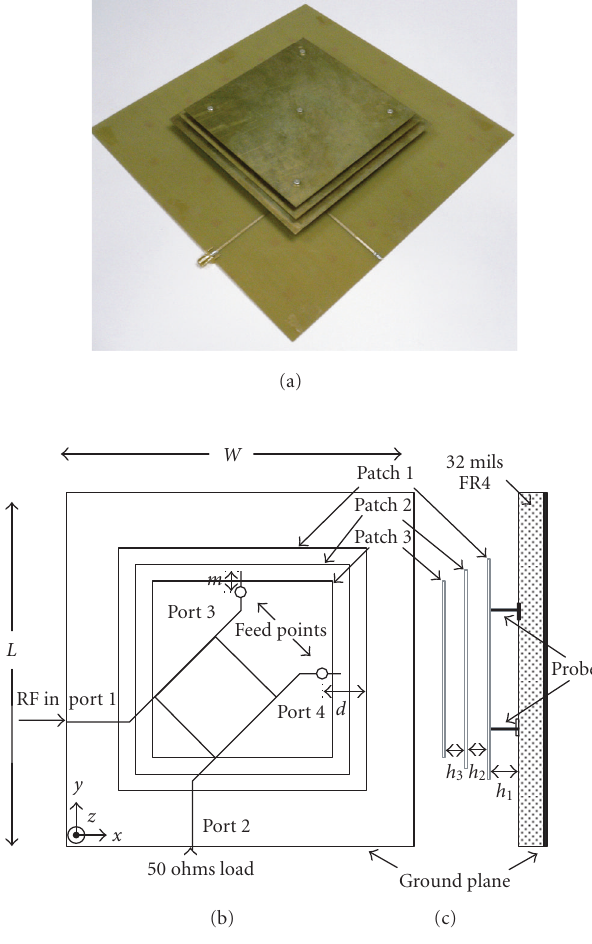
Figure 1: Geometry of the stacked patch antenna: (a) snapshot of proposed antenna; (b) schematic top view; (c) schematic side view.